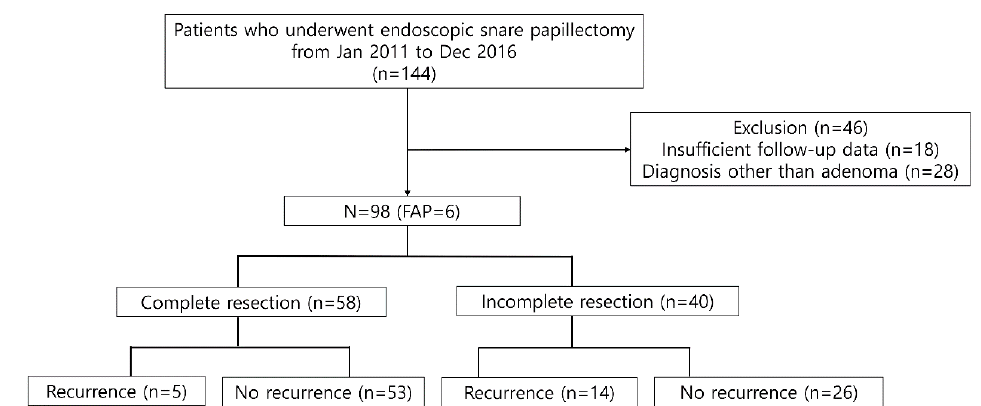
Figure 1. Flow chart of the patient inclusion process and recurrence rate according to resection margin after endoscopic snare papillectomy. FAP—familial adenomatous polyposis. Table 1. Baseline characteristics of the included patients.